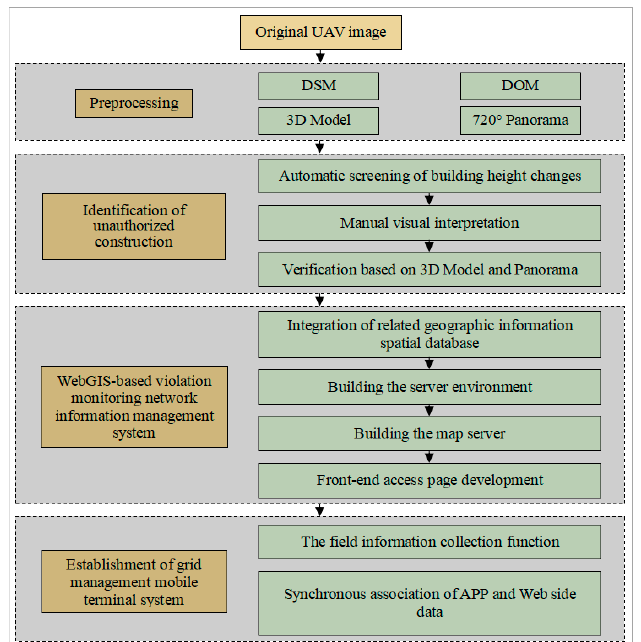
Figure 1. The built detection and management platform. DSM: digital surface model; DOM: digital orthophoto map